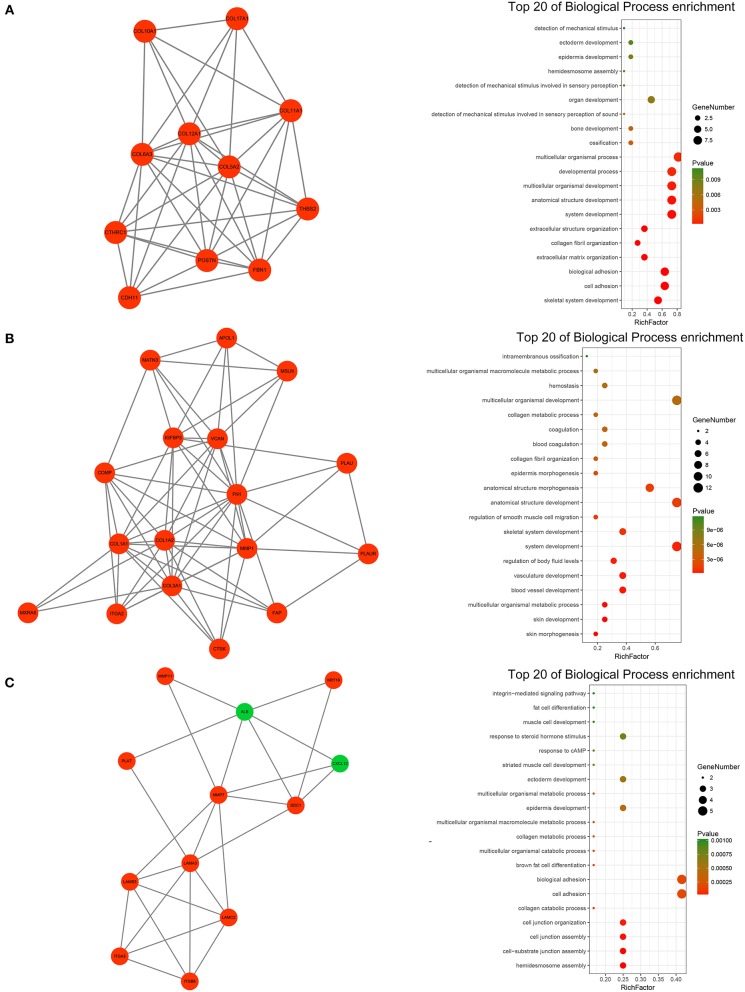
PPI network analysis of the DEGs. (A) Clustering module 1 with a score of 8.400 and its top 20 most enriched biological processes. (B) Clustering module 2 with a score of 8.125 and its top 20 most enriched biological processes. (C) Clustering module 3 with a score of 4.727 and its top 20 most enriched biological processes.